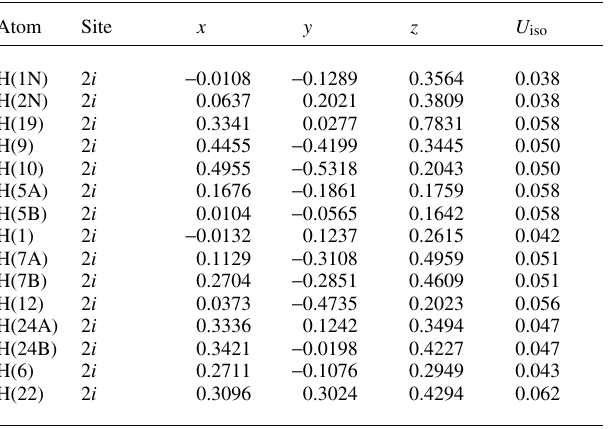
Table 2. Atomic coordinates and displacement parameters (in Å 2 )